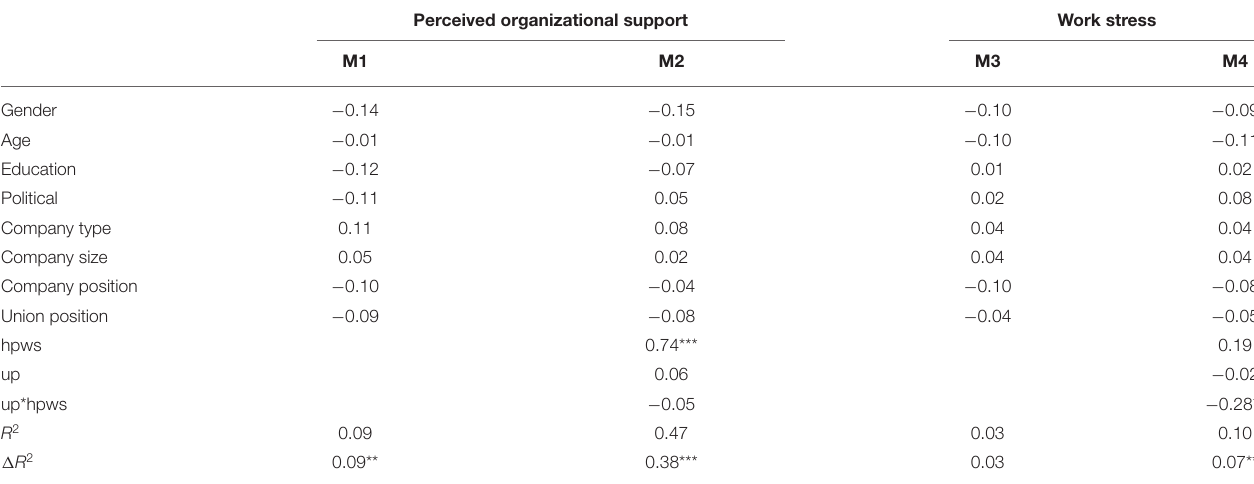
TABLE 4 | Moderating effect of union